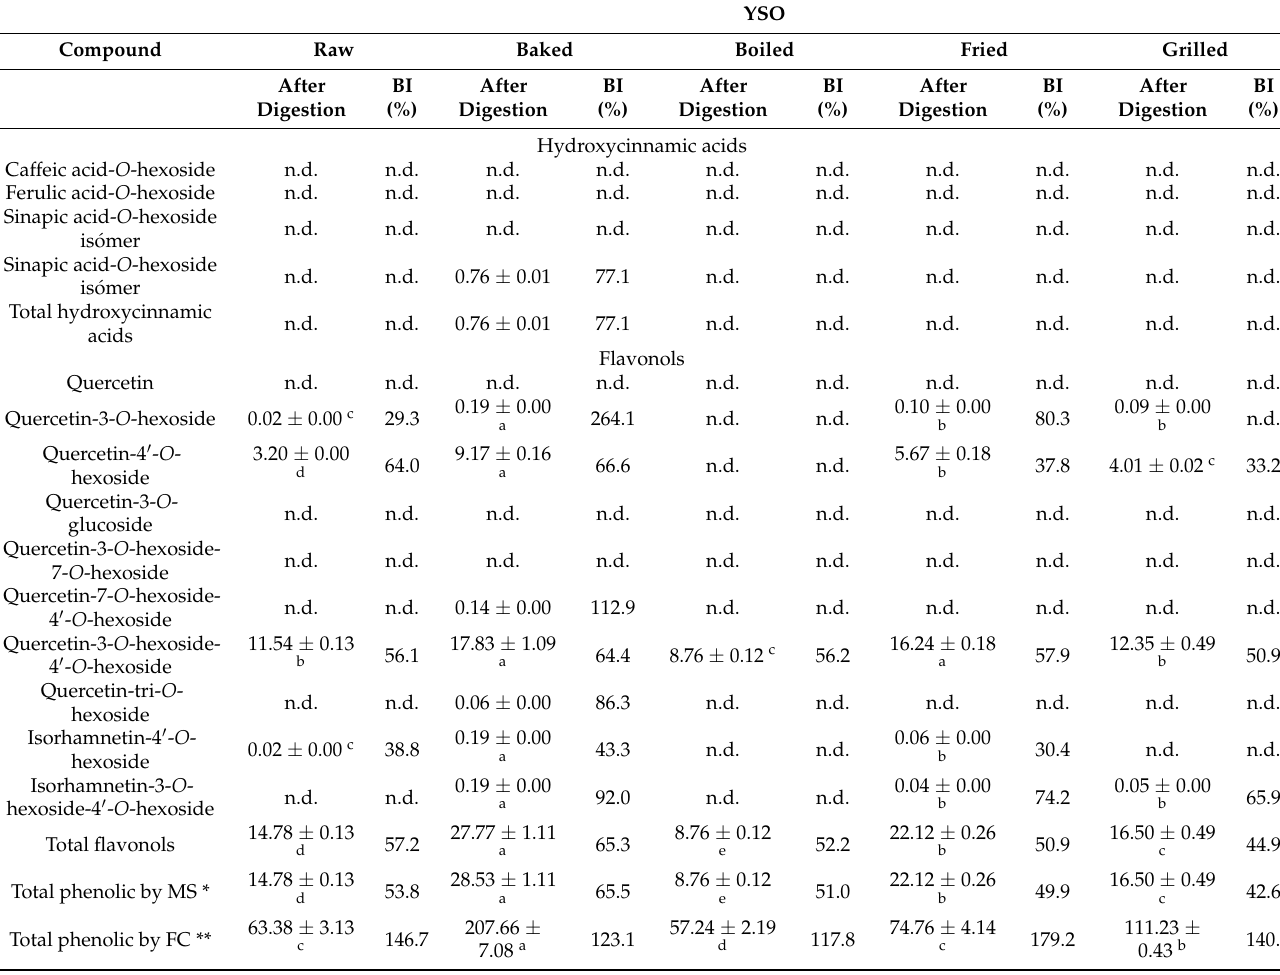
Table 4. Amount of phenolic compounds in raw and cooked yellow-skinned onion (YSO) after in vitro gastro-intestinal digestion. Results are expressed in mg of phenolic compound/100 of raw or cooked onion. Bioaccessibility index (BI) is the percentage ratio between the concentration after in vitro gastro-intestinal digestion and the concentration before digestion. YSO Compound Raw Baked Boiled Fried After BI After BI After BI After BI Digestion (%) Digestion (%) Digestion (%) Digestion (%)